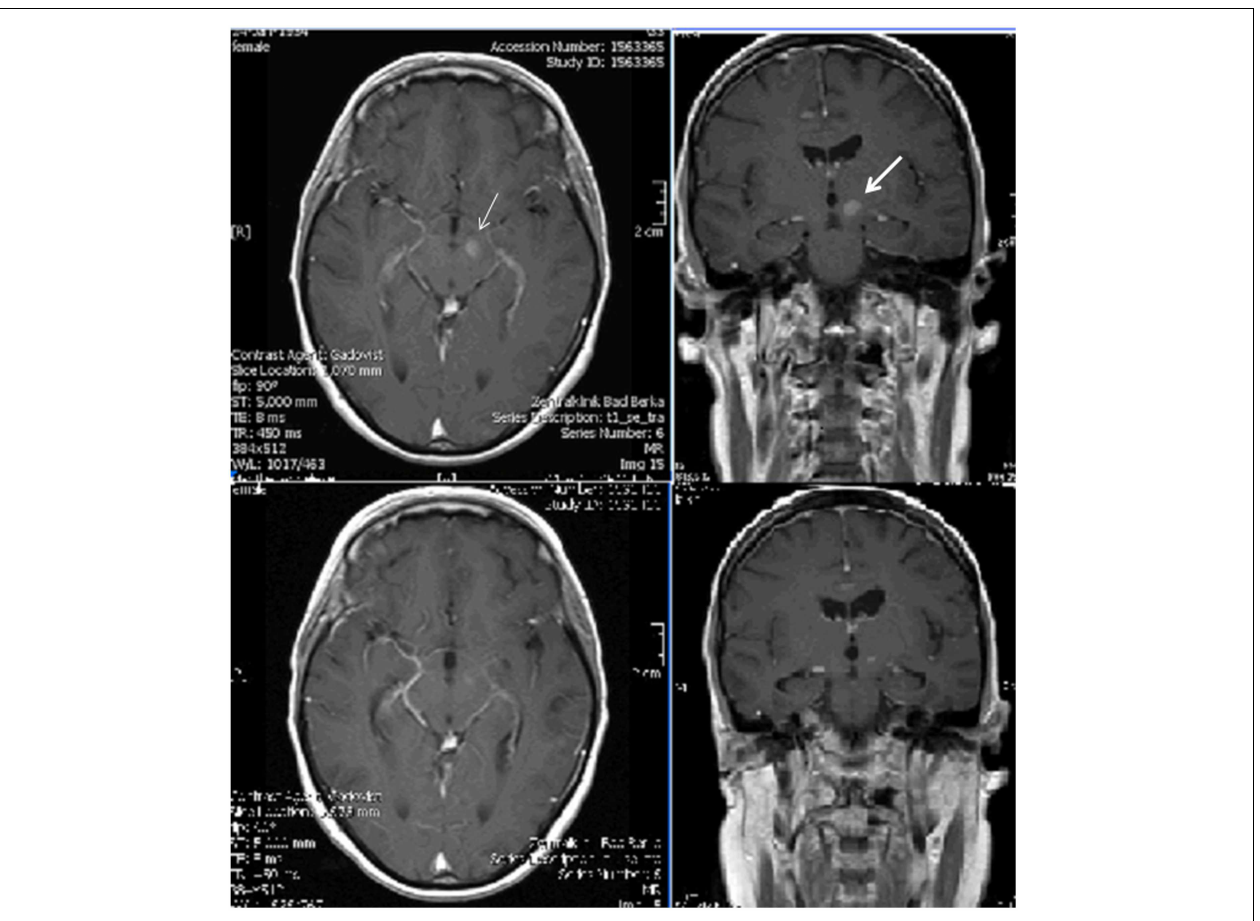
FIGURE 1 |Top:T1-weighted gadolinium-enhanced axial and coronal magnetic resonance images before brain radiation therapy: lesions on the left side of the mesencephalon (left, thin arrow) in the left thalamus (right, thick arrow); bottom: corresponding images after therapy presenting much less clear lesions .